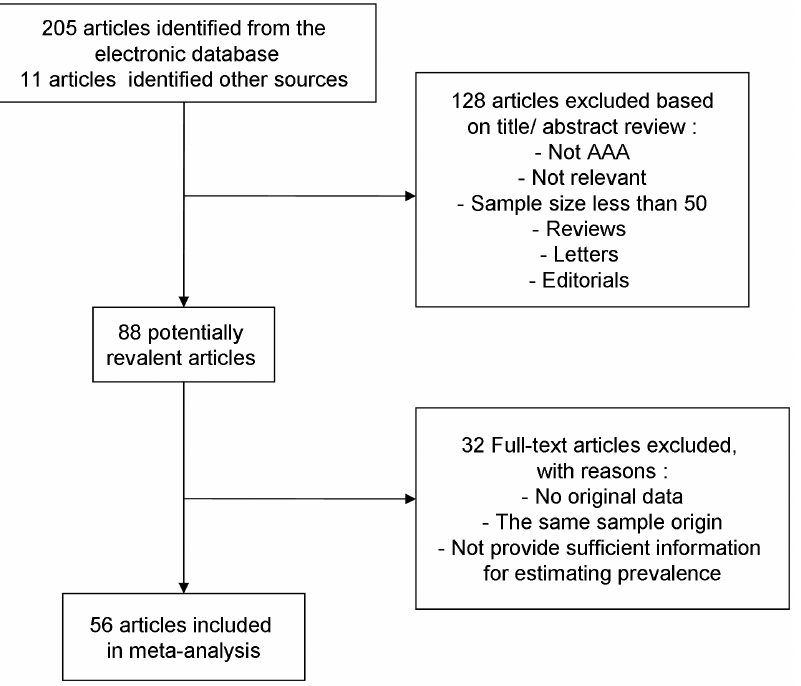
Figure 1. Flow chart demonstrating those studies that were processed for inclusion in the meta-analysis.